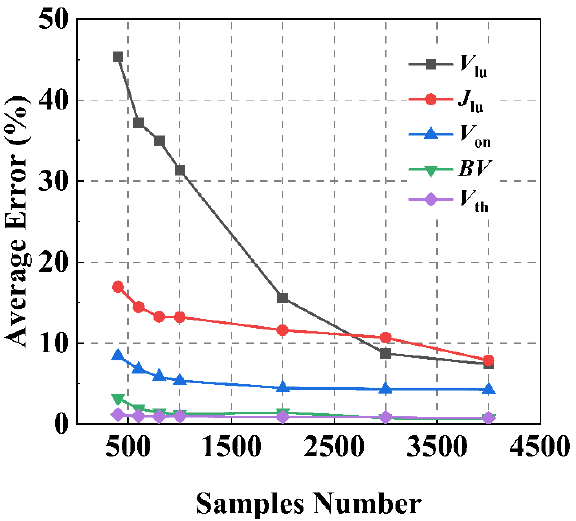
Figure 5. Curves of average error for static characteristic parameters varying with the number of training set samples based on the ANN